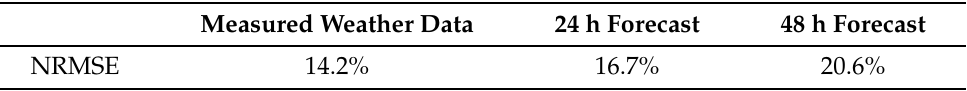
Table 8. Comparison of heating electricity demand prediction error according to weather data forecasting duration.